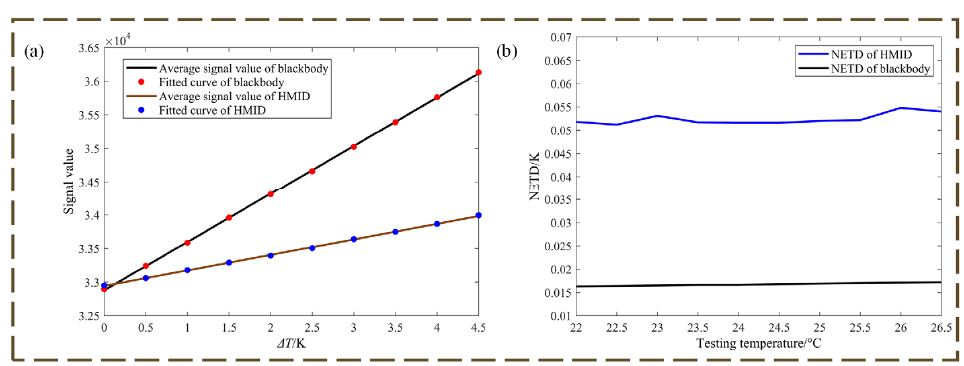
Figure 10. ( a ) Curve chart of system SiTF; ( b ) Curve chart of system NETD, the data are flat.